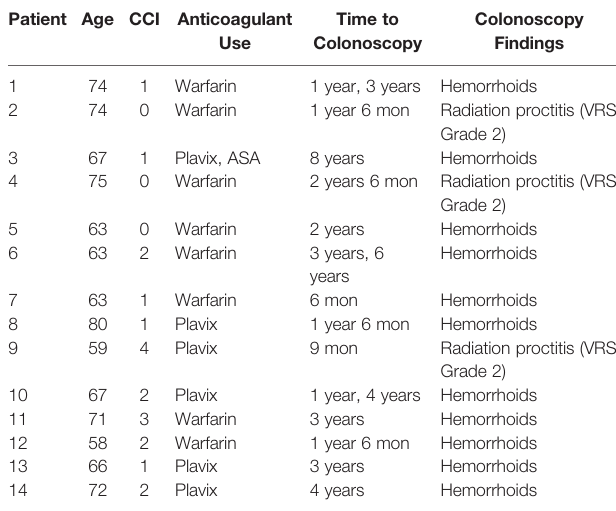
TABLE 4 | Results of